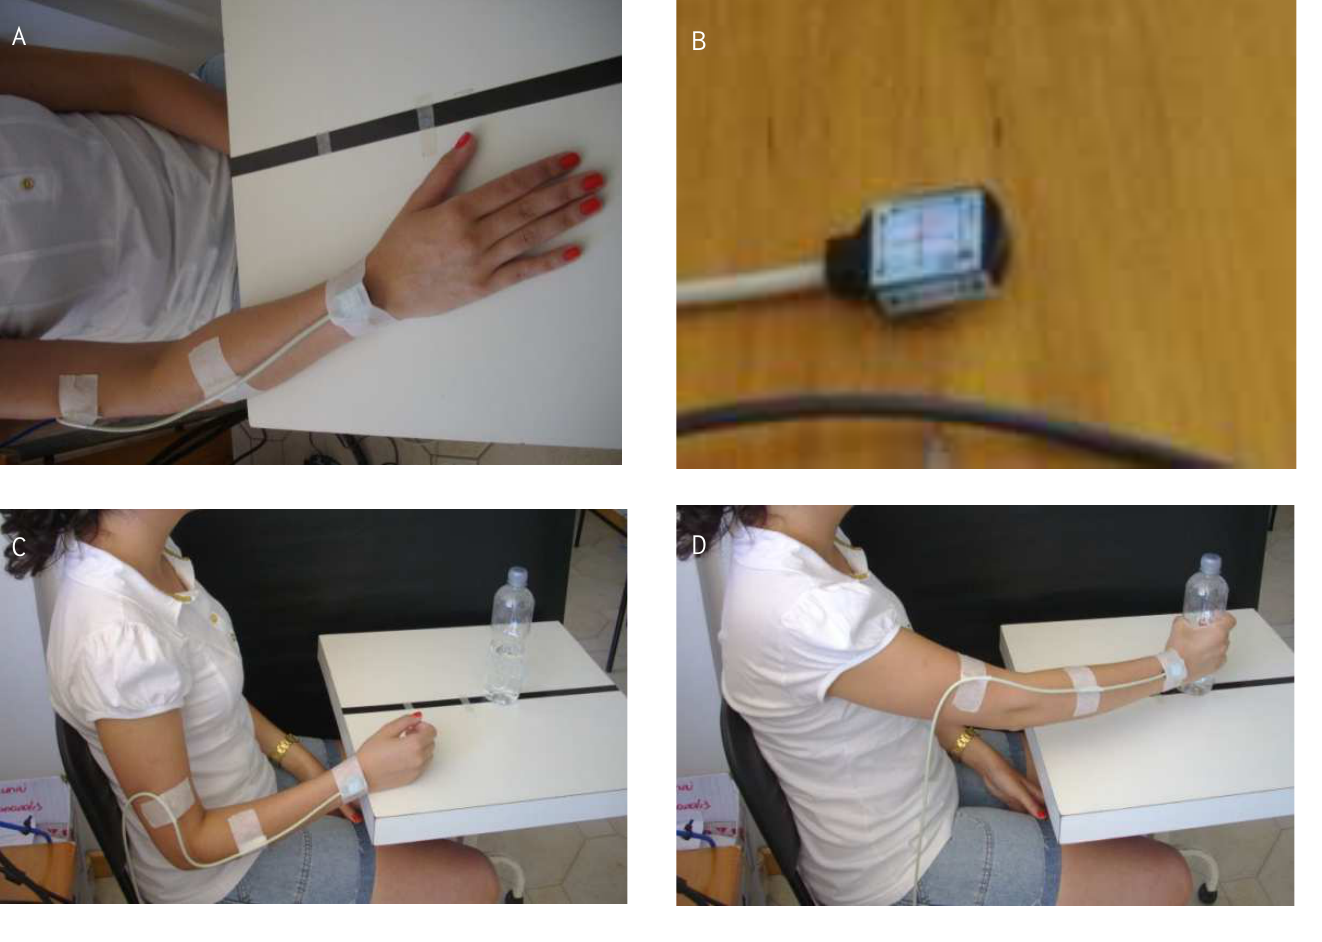
Figure 1. Accelerometer fixation (A); accelerometer (B); analyzed task - reaching and grasping a bottle (C and D): initial position (C) end position